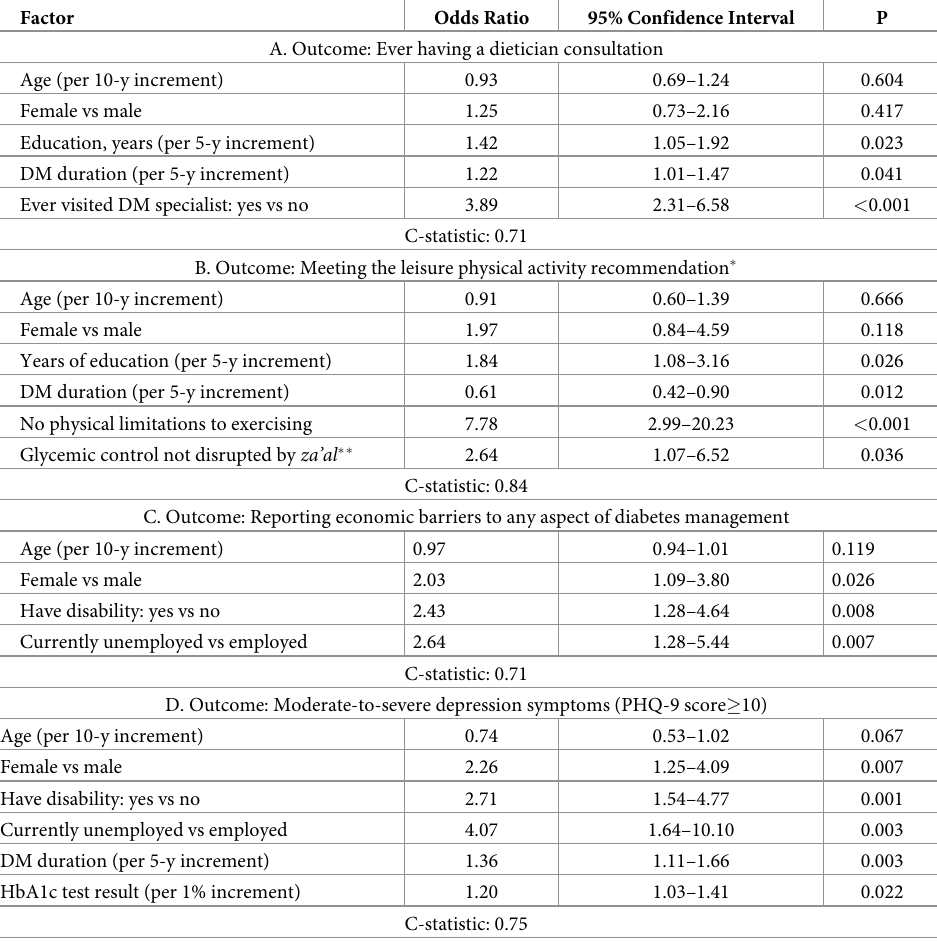
physical activity. � � 2.5 hrs moderate-to-vigorous